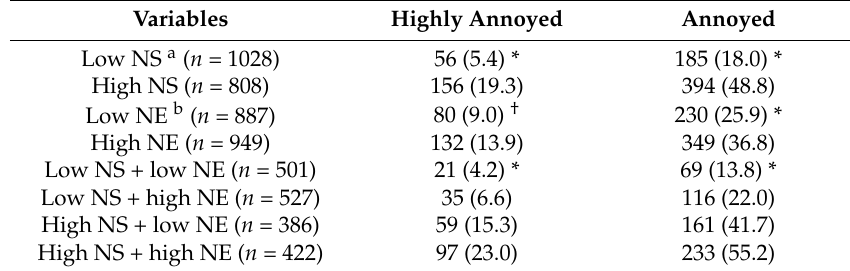
Table 2. Proportion of highly annoyed and annoyed according to noise exposure, noise sensitivity, and a complex of noise sensitivity and